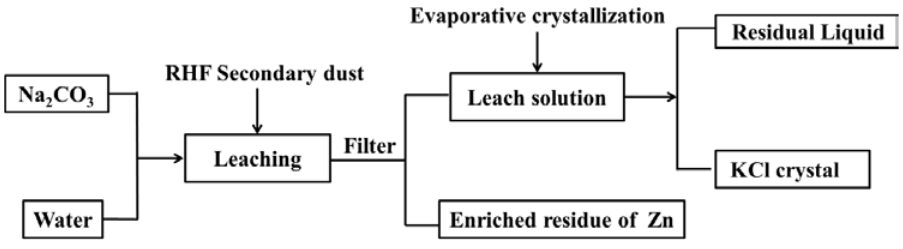
Figure 2. Process flow chart of R otary Hearth Furnace secondary dust alkali-evaporation crystallization.